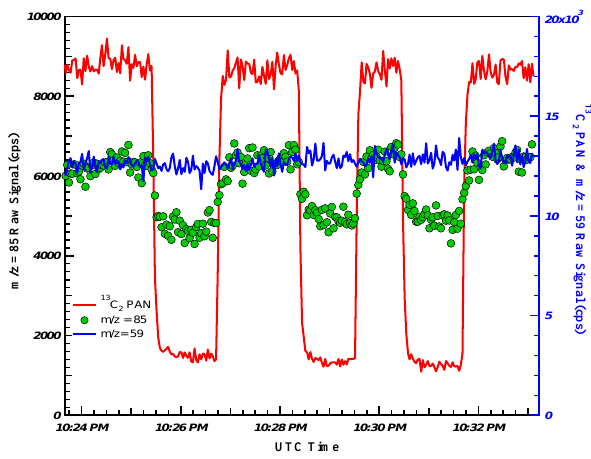
Fig. 15. Switching the 13 C 2 PAN standard in and out of the sam- ple stream introduces modulation in the m/z =85 signal. This arti- fact on the MPAN signal is caused by proton transfer ionization of methacrylic acid by the acetate